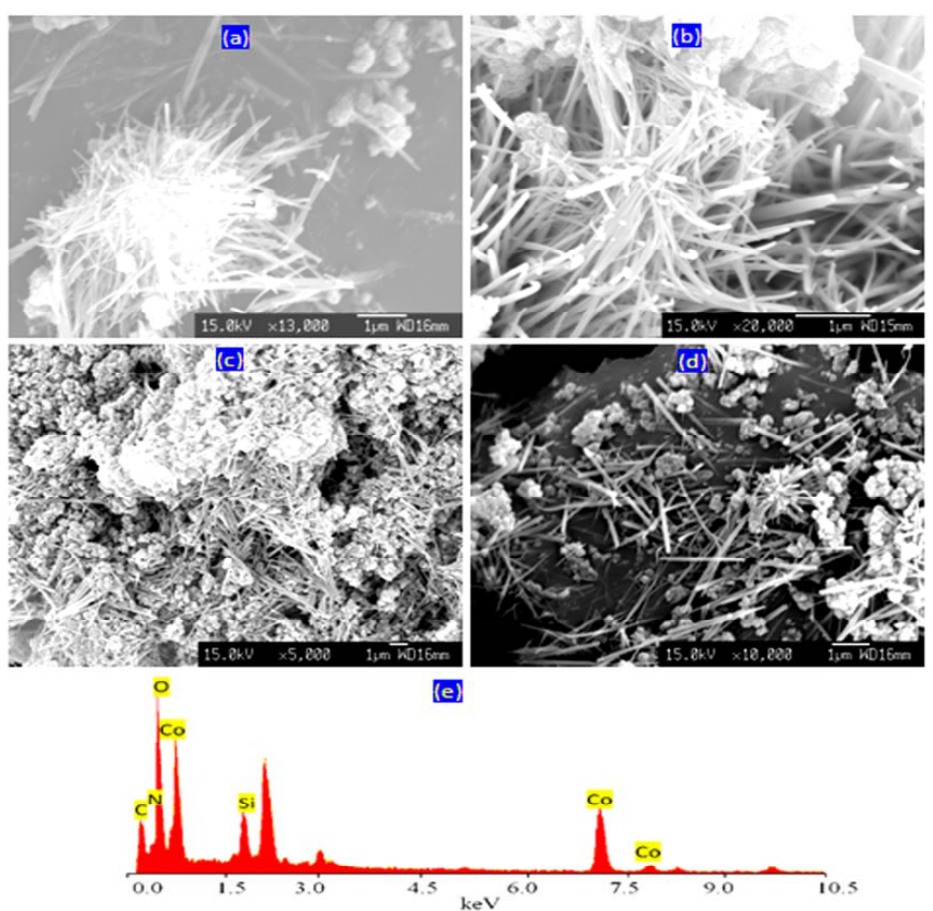
Figure 1. SEM images of samples ( a ) SiCo ‐ 1 ‐ 16; ( b ) SiCo ‐ 1 ‐ 26; ( c , d ) SiCo ‐ 2 ‐ 36; and ( e ) EDX analysis of SiCo ‐ 1 ‐ 26.